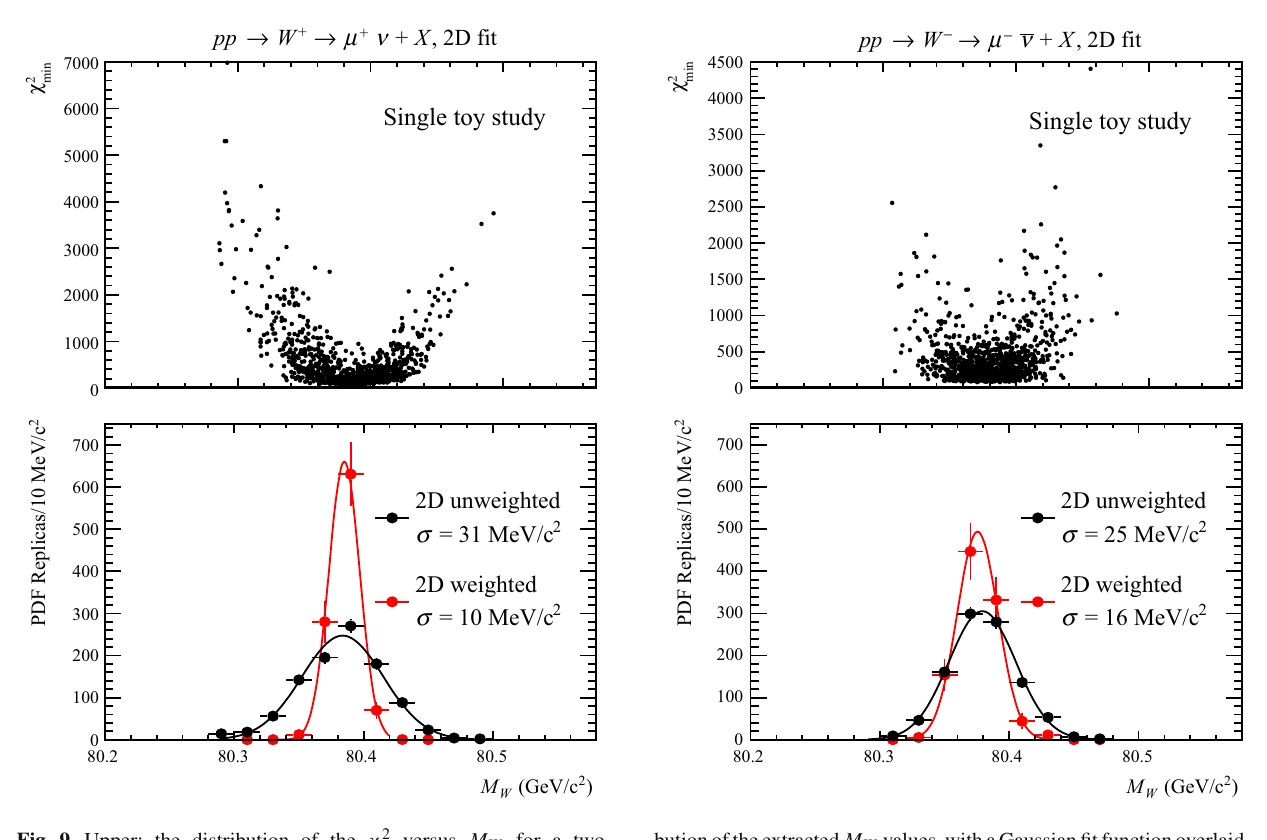
dimensional fit to a single toy dataset. The distributions of M W values are shown with and without the replica